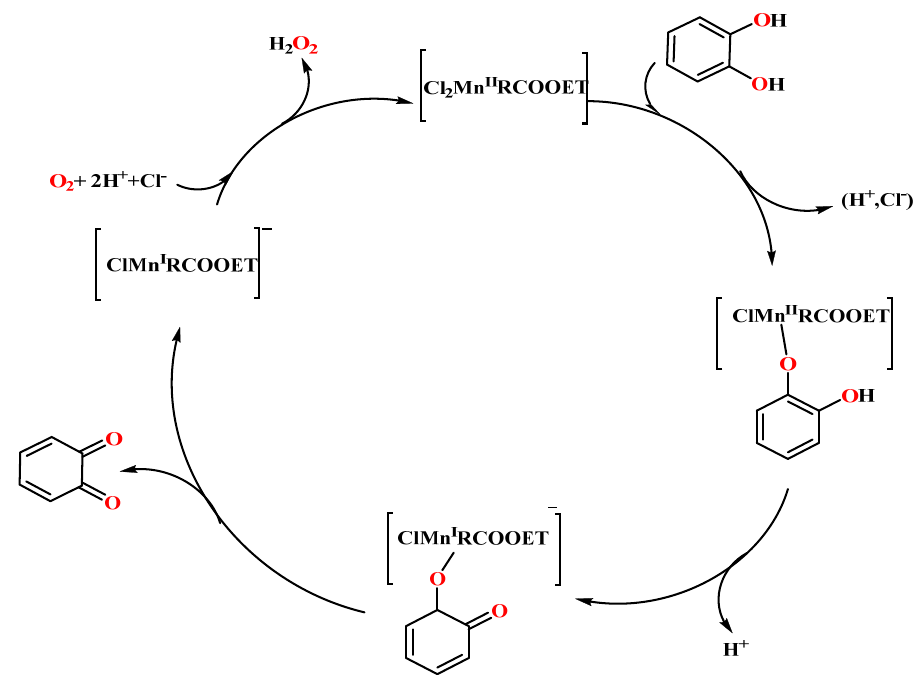
10 of 16 Figure 9. UV ‐ visible spectrum of absorption of o ‐ quinone in the presence of the pre ‐ synthesized [(Cl) 2 Mn(RCOOET)] in MeOH. 2.7. Proposed Mechanism of Action of Catechol